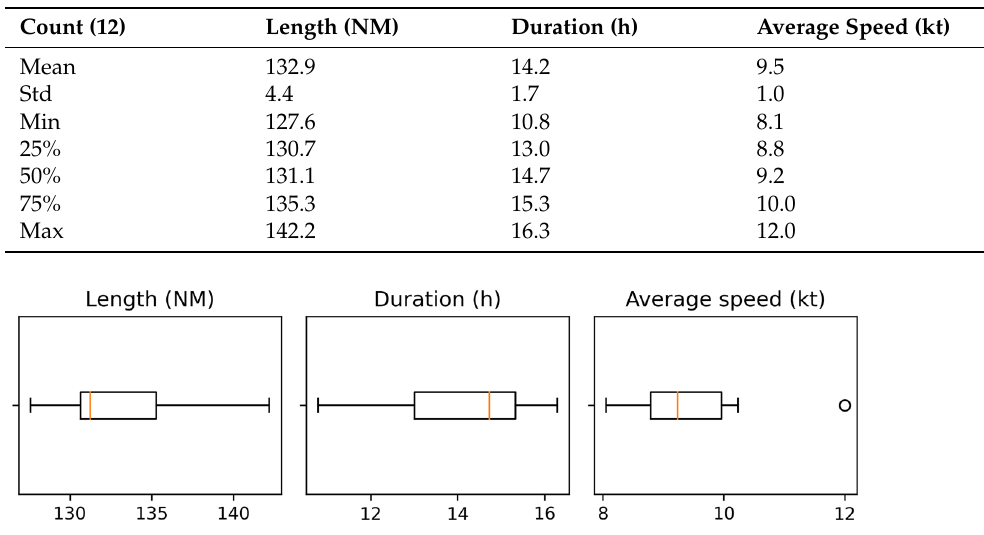
Table 2. Statistical summary of voyage lengths.